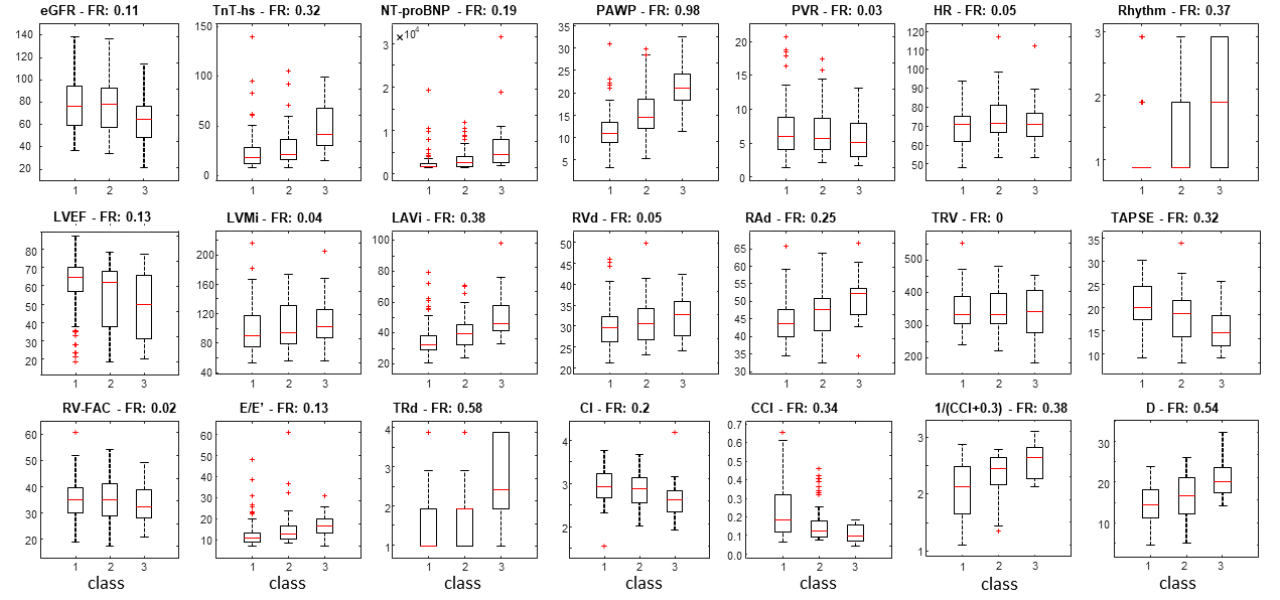
Figure 3. Box and whisker plots of the different features, dividing the dataset in the 3 RAP classes (1 = low, 2 = intermediate, 3 = high). The average of Fisher ratios (FR) is also indicated. CI: cardiac index; CCI: cardiac caval index; eGFR: estimate glomerular filtration rate; hs-TnT: high sensitivity troponin T; D: inferior vena cava diameter; LAVI: left atria volume index; LVEF: left ventricular ejection fraction; LVMI: left ventricular mass index; NT-proBNP: amino terminal pro brain natriuretic peptide; PAWP: precapillary artery wedge pressure; PVR: pulmonary vascular resistances; RAd: right atrial diameter; RVd: right ventricular diameter; RV-FAC: right ventricular fractional area change; TAPSE: tricuspid annular plane excursion; TVR: tricuspid regurgitation velocity; TRd: tricuspid regurgitation